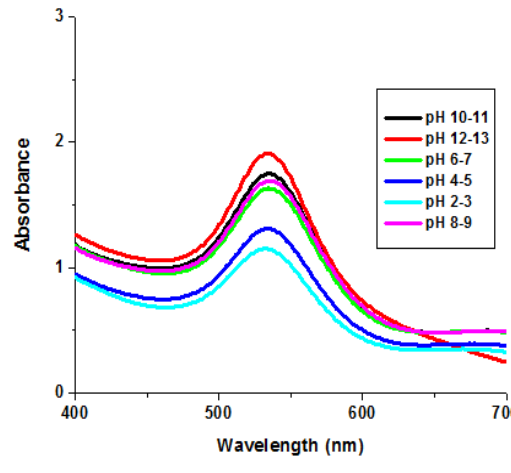
Figure 4. Effect of pH on GNPs.